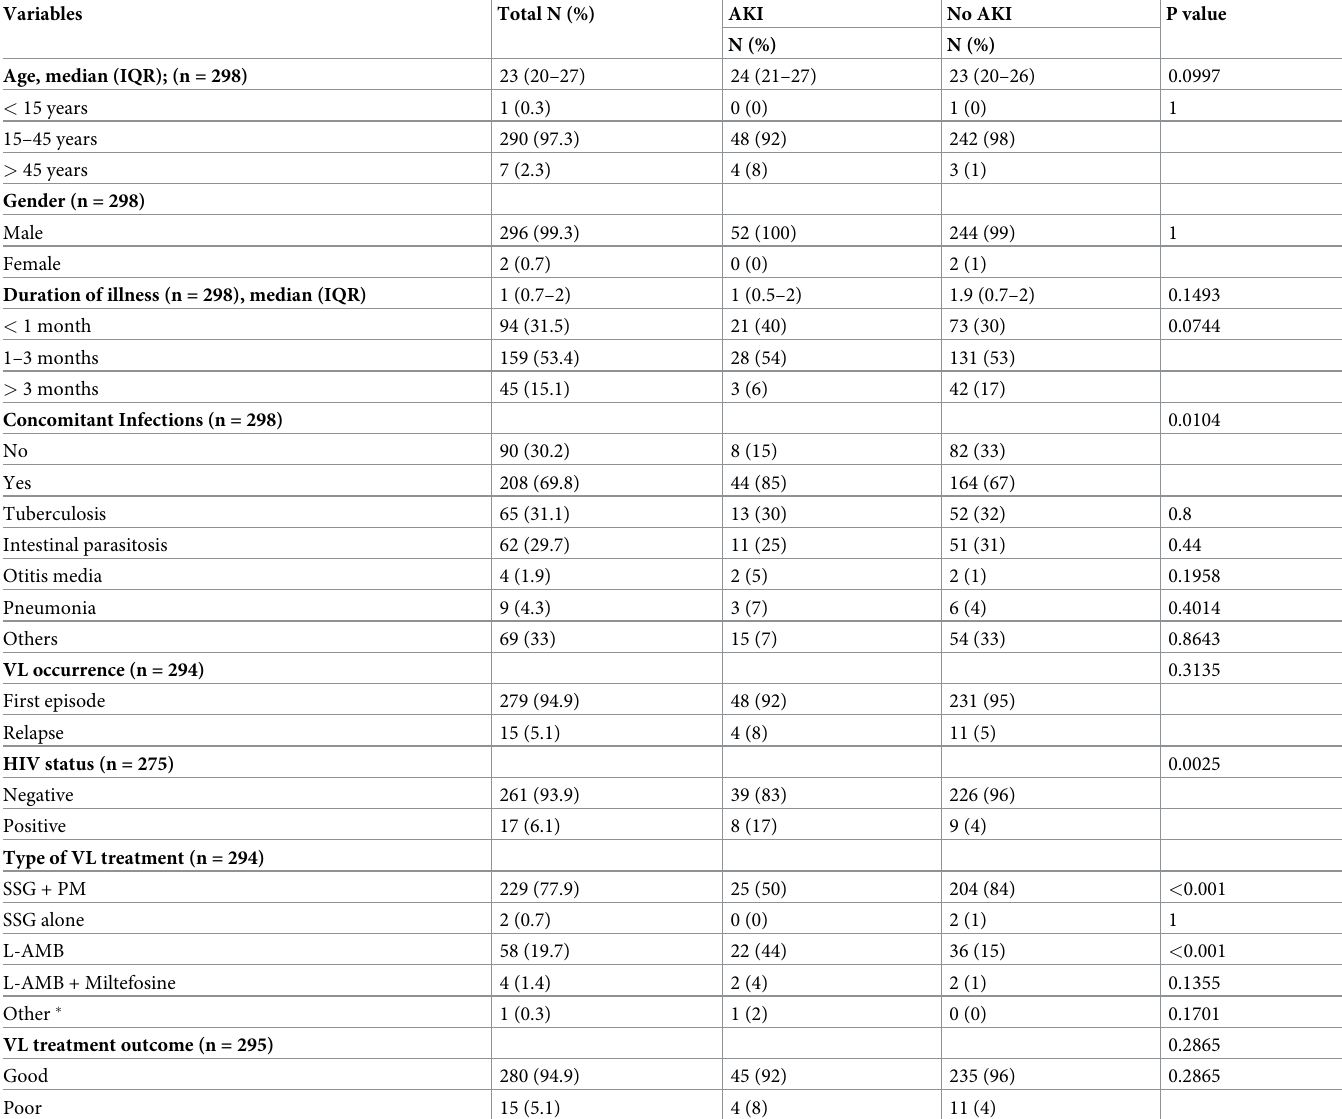
Table 1. Baseline demographic and clinical characteristics of VL patients at LRTC between January 2019 –December 2019, Gondar, Ethiopia, N =